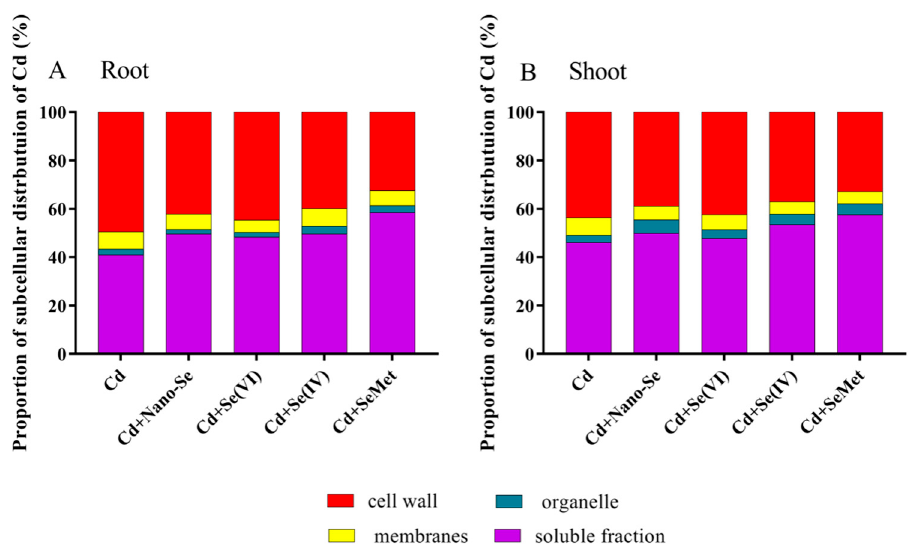
Figure 2. Effects of different Se forms on subcellular distribution of Cd in the roots ( A ) and shoots ( B ) of rice seedlings in the presence of Cd.